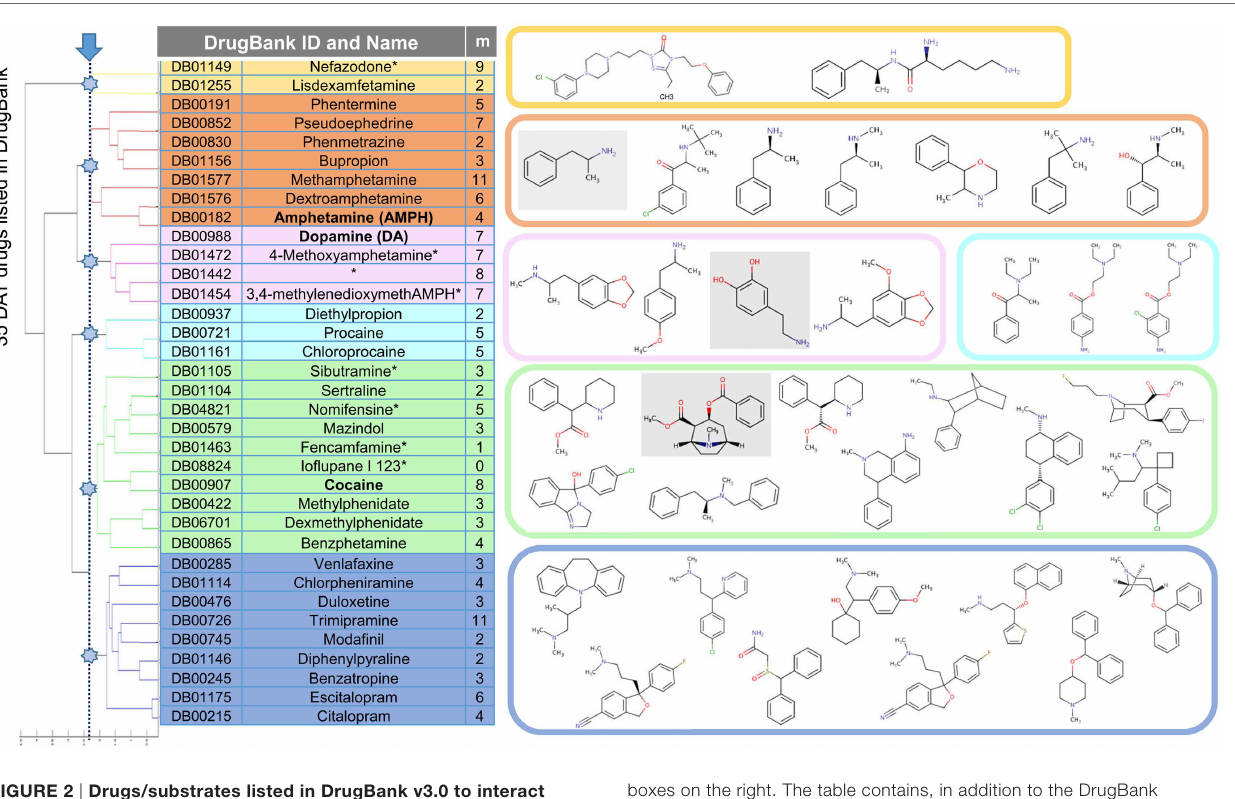
Figure 2 | Drugs/substrates listed in DrugBank v3.0 to interact with DaT, clustered in six groups based on their structural and chemical similarities . Membership of each cluster is listed, along with the structures (color-coded). Three substrates/drugs on which we focus, dopamine, amphetamine (AMPH), and cocaine, are highlighted in gray